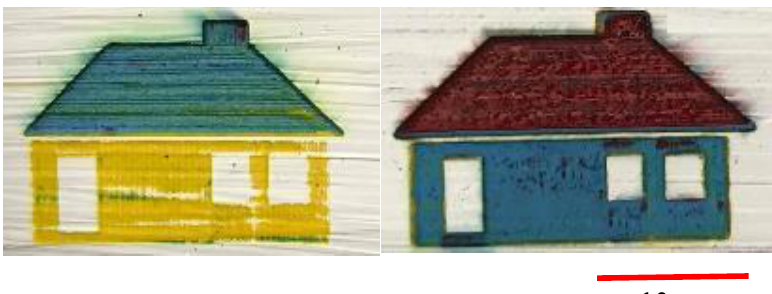
Figure 20. Different designs of house elements.